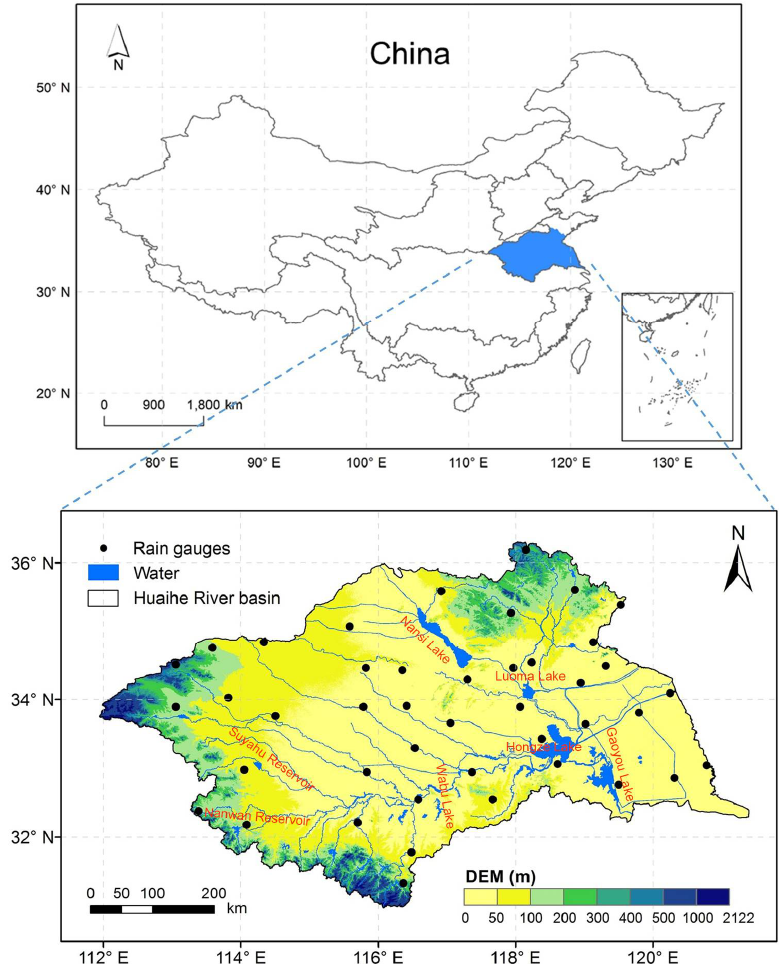
Figure 1. Geographical location, DEM and the distribution of rain gauges in the Huaihe River basin.